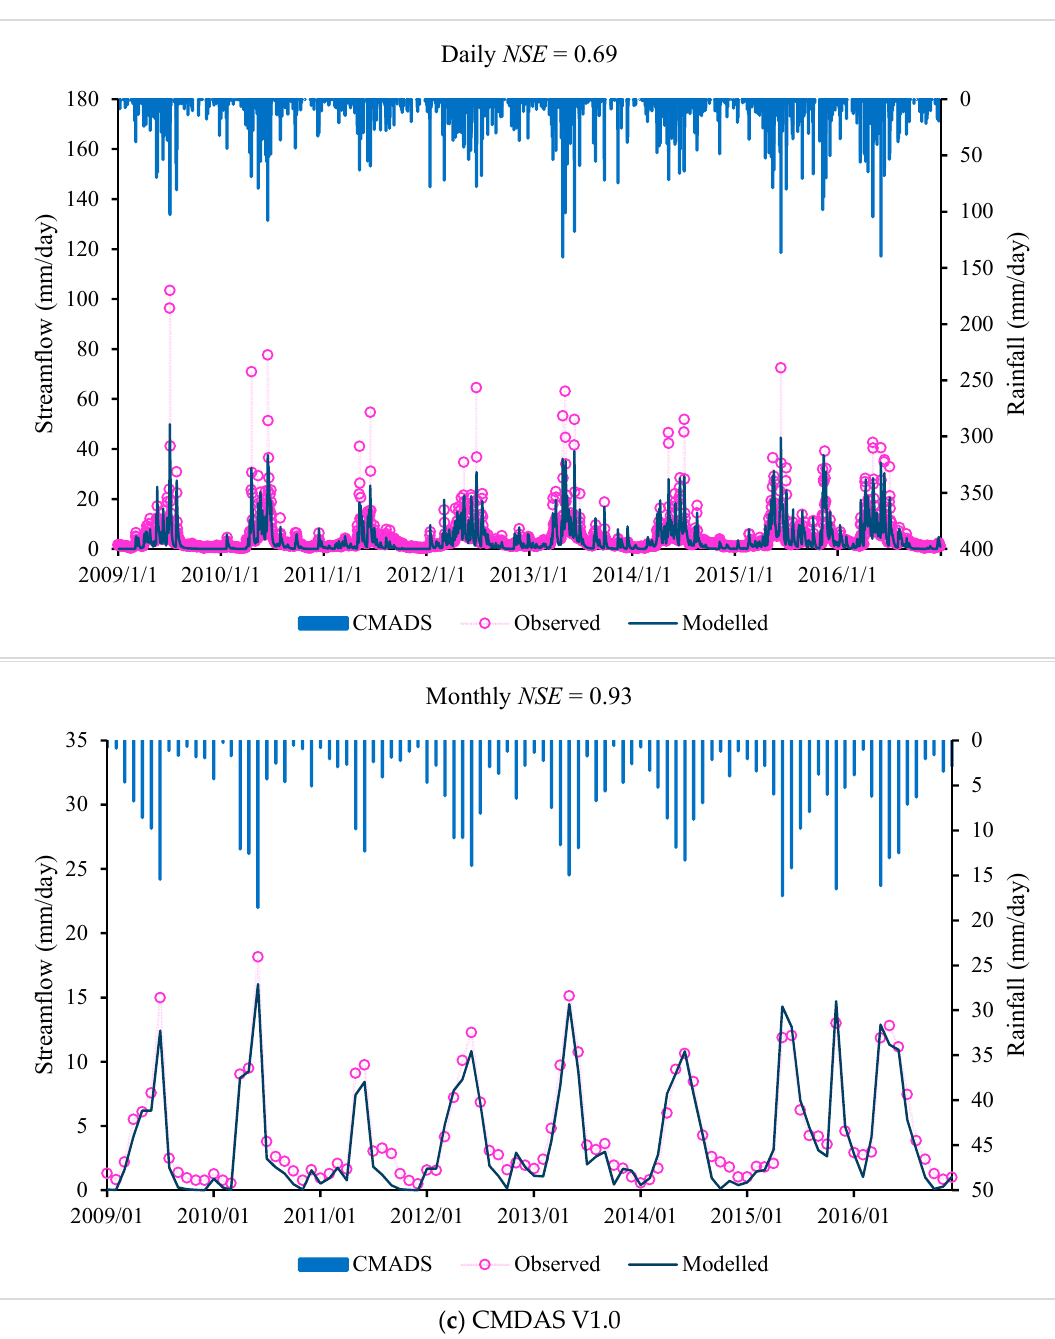
Figure 3. Observed and IHACRES-model-simulated daily and monthly runoffs for ( a ) Gauge- interpolated, ( b ) TMPA-3B42V7 and ( c ) CMDAS rainfall datasets (for the IHACRES model calibrated using NSE as the objective function).